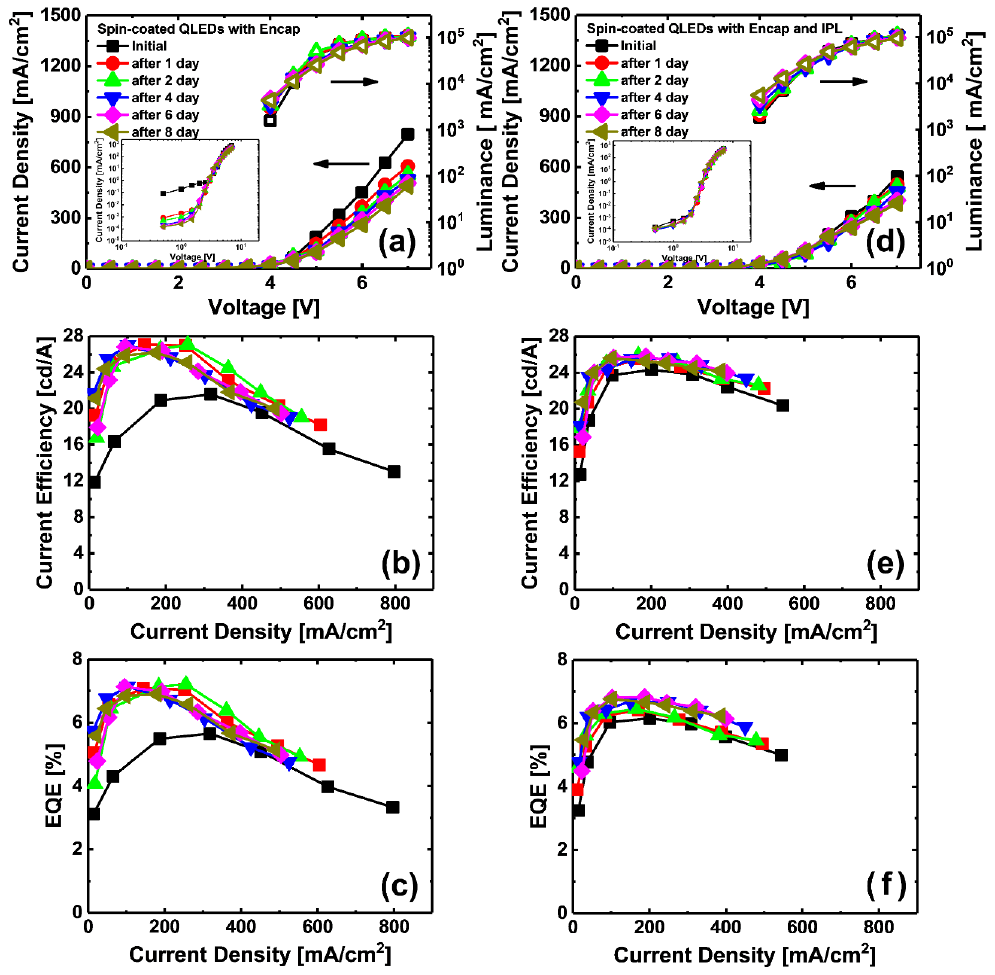
Figure 4. Current density and current–voltage–luminance (IVL) characteristics of the QLEDs ( a – c ) with and ( d – f ) without IPL post-treatment. (Inset of ( a ) and ( d ): log–log plot of the current density curve.) Table 1. The IVL characteristics and stabilization time of device time-dependency of QLEDs by IPL post-treatment.